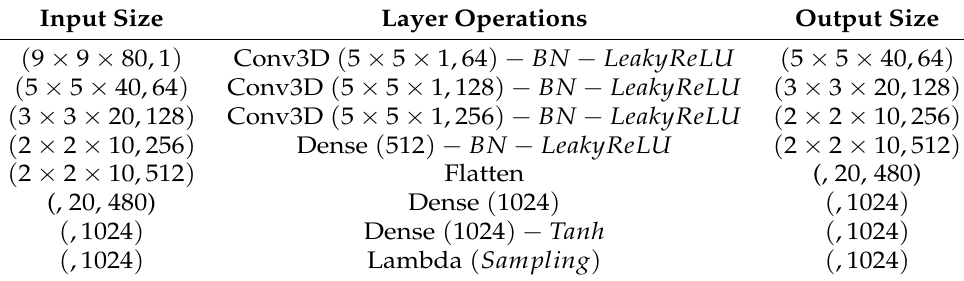
Table 2. The implementation details of the Spatial feature extraction E 2